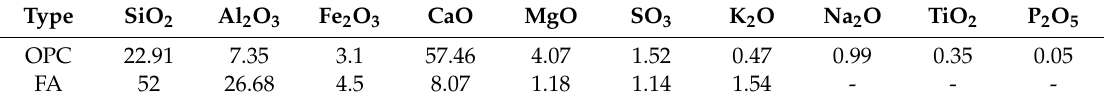
Table 2. Chemical composition of ordinary Portland cement (OPC) and fly ash (FA) (%).